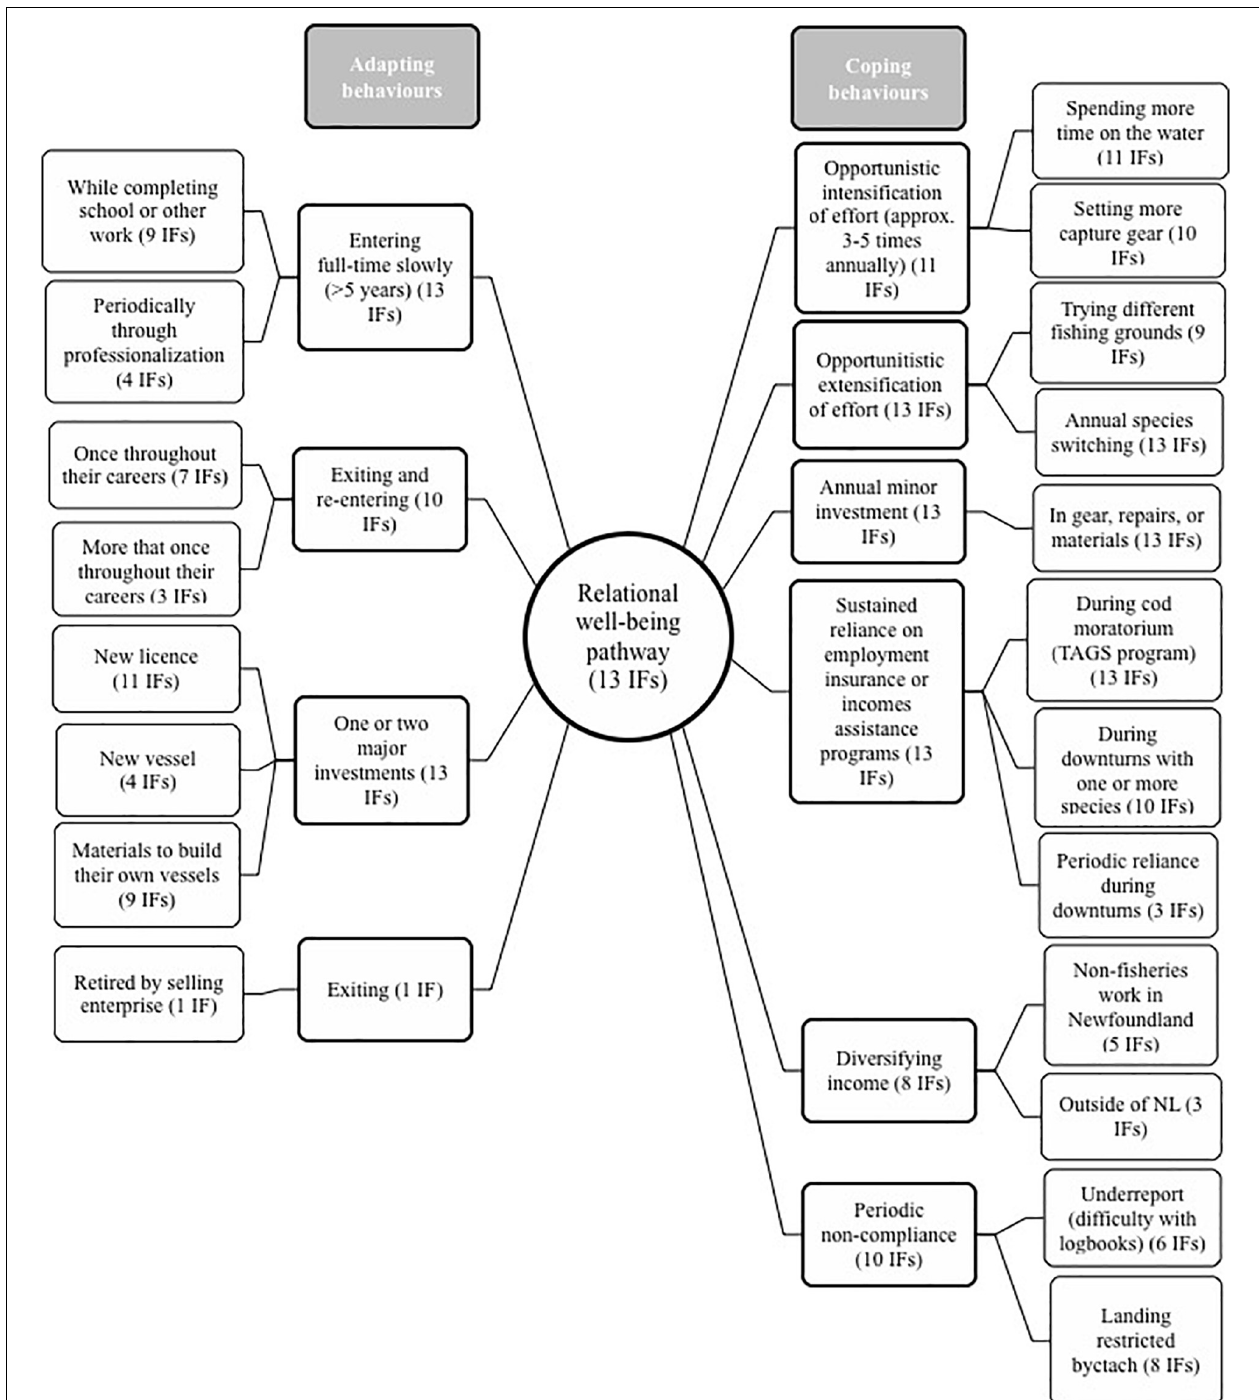
FIGURE 5 | The relational well-being pathway